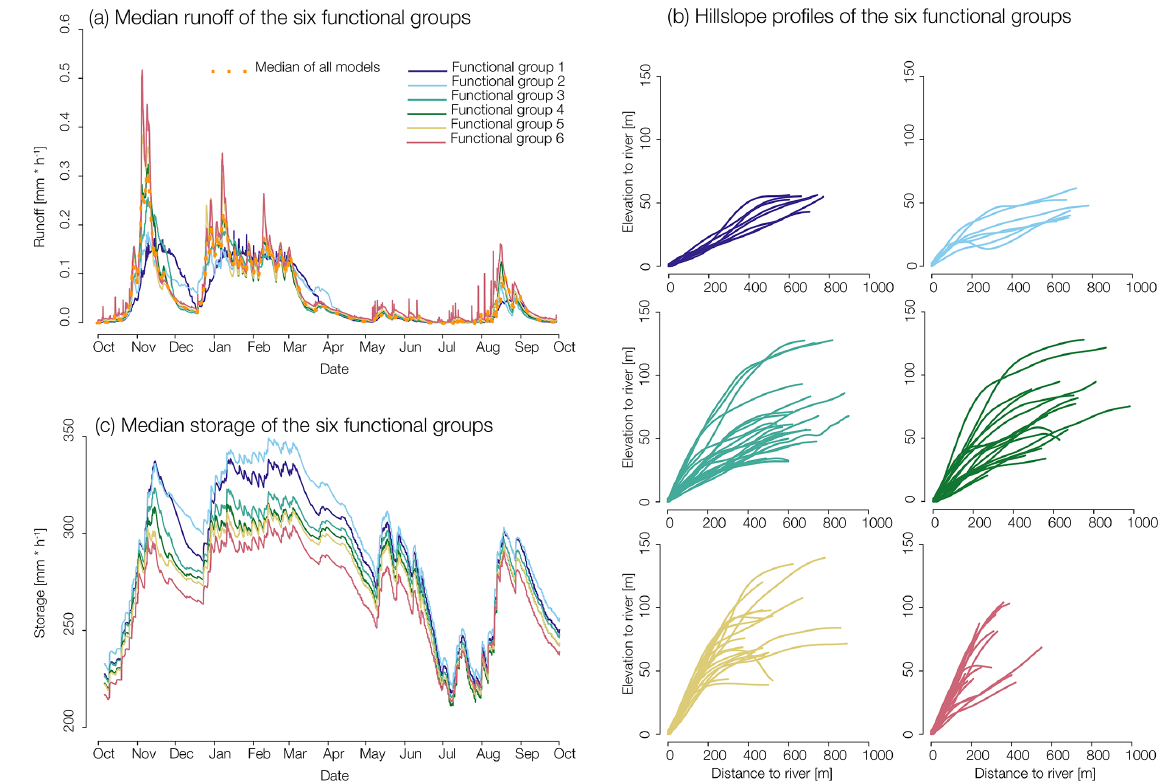
Figure 5. (a) Median runoff of the six functional groups; (b) corresponding hillslope profiles with the elevation to river on the y axis and distance to river on the x axis for each functional group. (c) Median storage of the six functional groups.